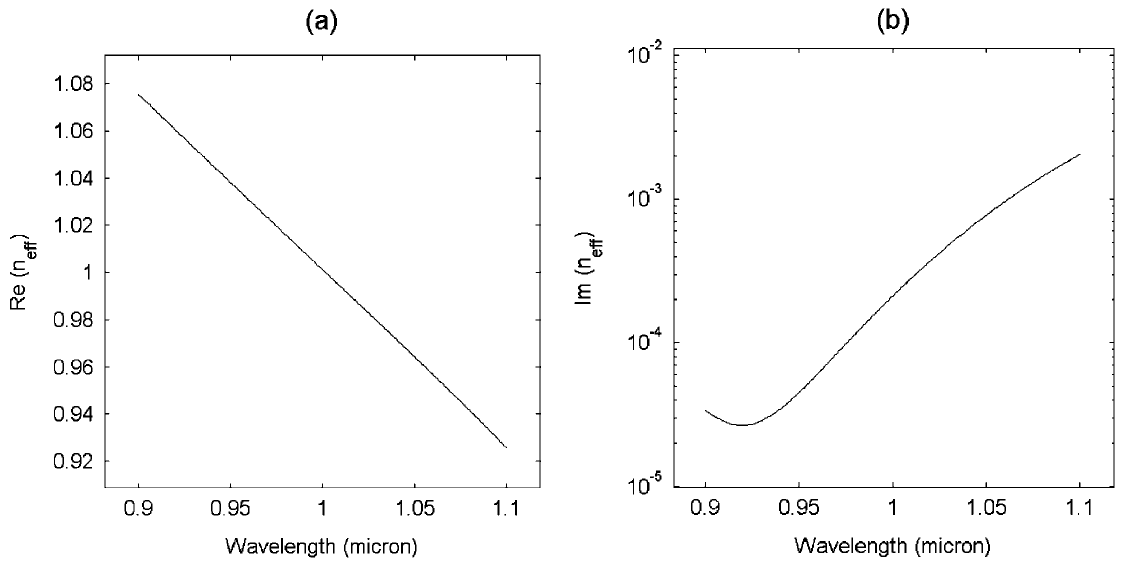
FIG. 6. (a) Real part and (b) imaginary part of the defect mode’s effective refractive index as a function of free-space wavelength for a six-layer PBG fiber ( a ¼ 1 : 3 (cid:3) m ) as calculated with the multipole